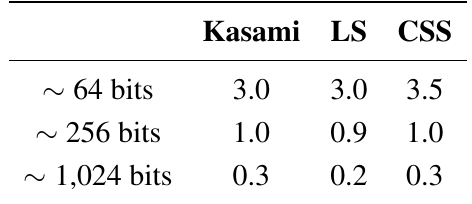
Table 2. Receiver velocities (m/s) whose θ absorption are